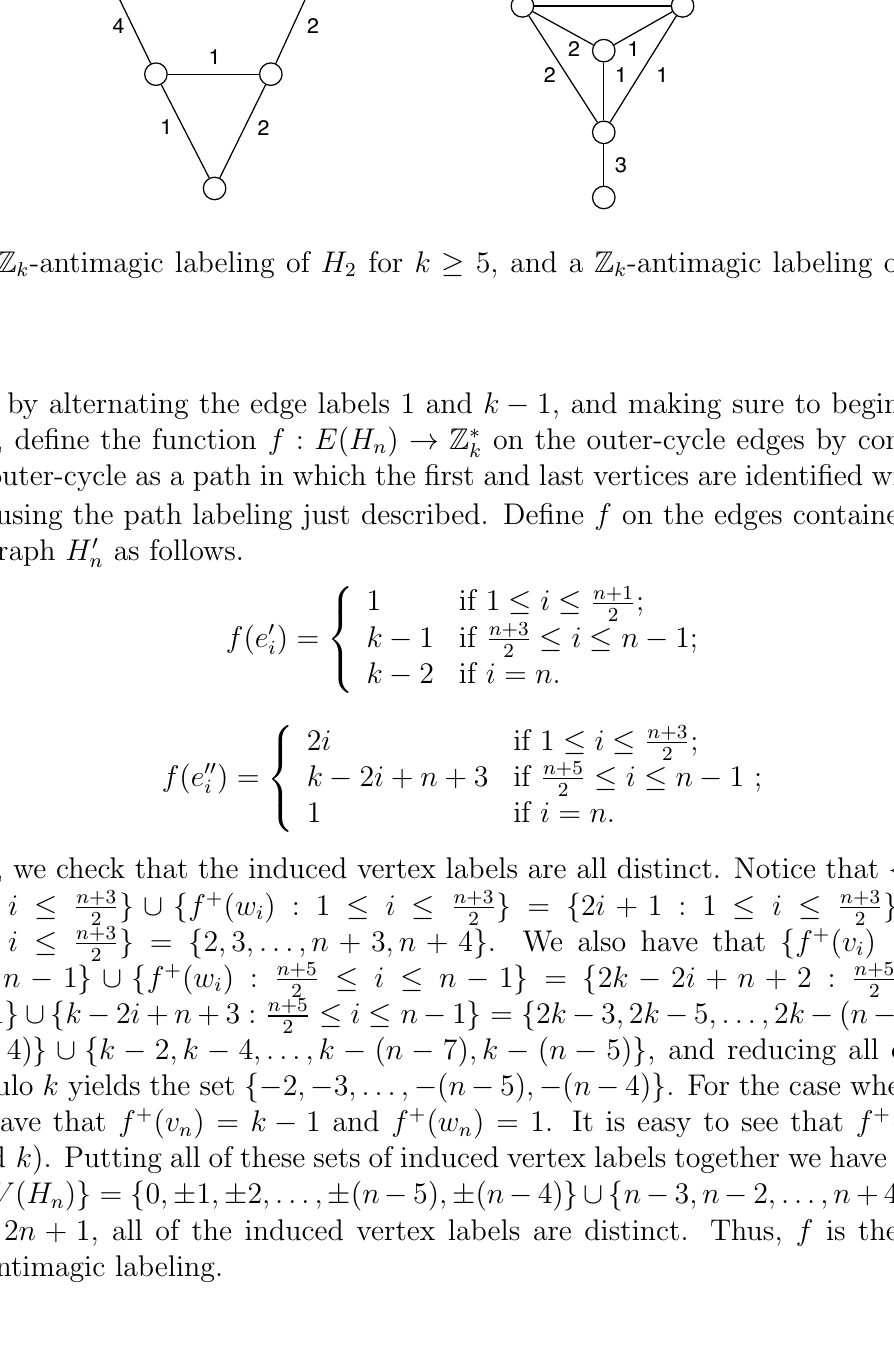
-antimagic labeling of H k